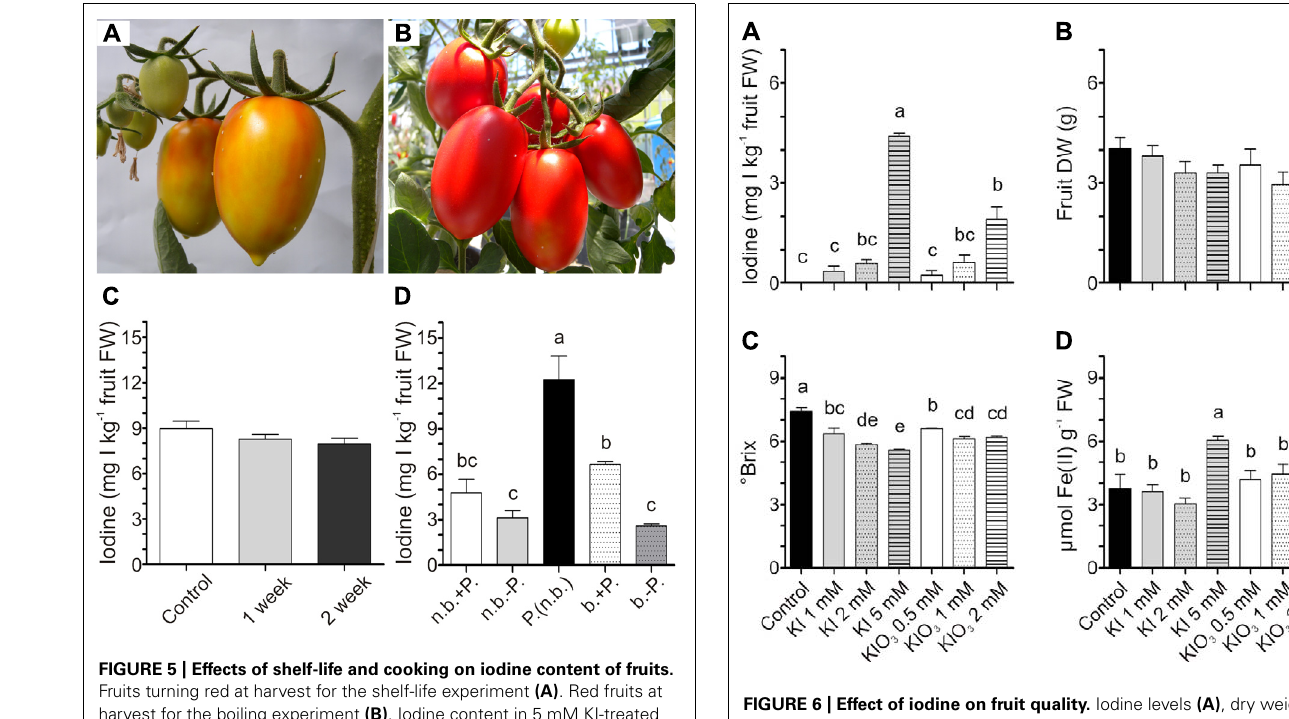
FIGURE 6 | Effect of iodine on fruit quality. Iodine levels (A) , dry weight (DW) (B) , sugar content (C) , and antioxidant capacity (D) measured in fruits collected at the red ripening stage from the first truss of plants treated eight times with 0–5 mM KI or 0–2 mM KIO 3 . Data were subjected to one-way analysis of variance (ANOVA) and the means were separated using the F -test (95% confidence